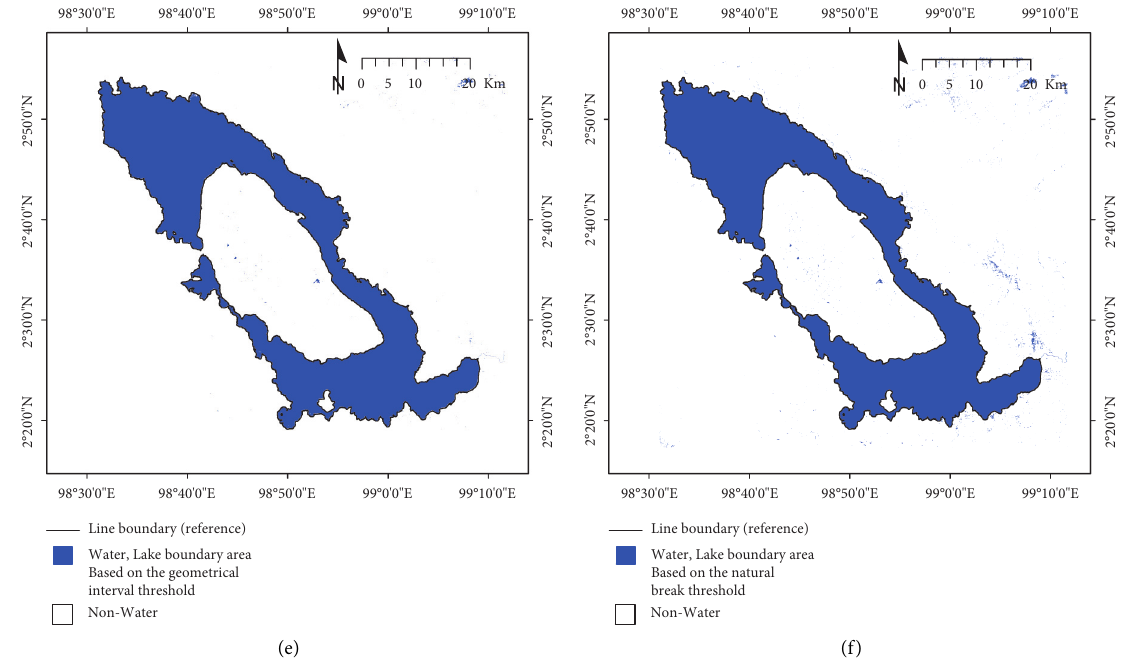
Figure 10: Test case results of the AWEI threshold improvement to detect lake surface water (water and nonwater class) in Toba lake: (a) map references were obtained based on the on-screen visual digitization of Landsat 8 imagery from 2019; (b) classification based on the normal threshold; (c) classification based on the equal interval threshold; (d) classification based on the quantile threshold; (e) classification based on the geometrical interval threshold; and (f) classification based on the natural break threshold.